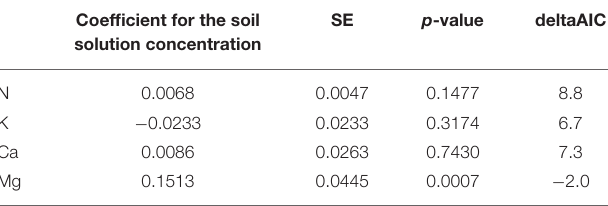
TABLE 2 | Regression coefficients for the relation between foliar nutrient concentrations and the concentration of the corresponding element in soil solution for beech (19 plots).